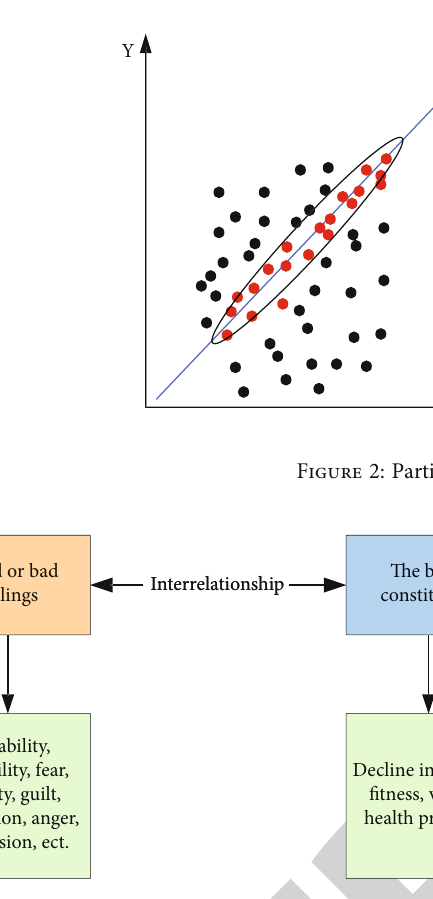
Figure 3: Relationship diagram of emotion and